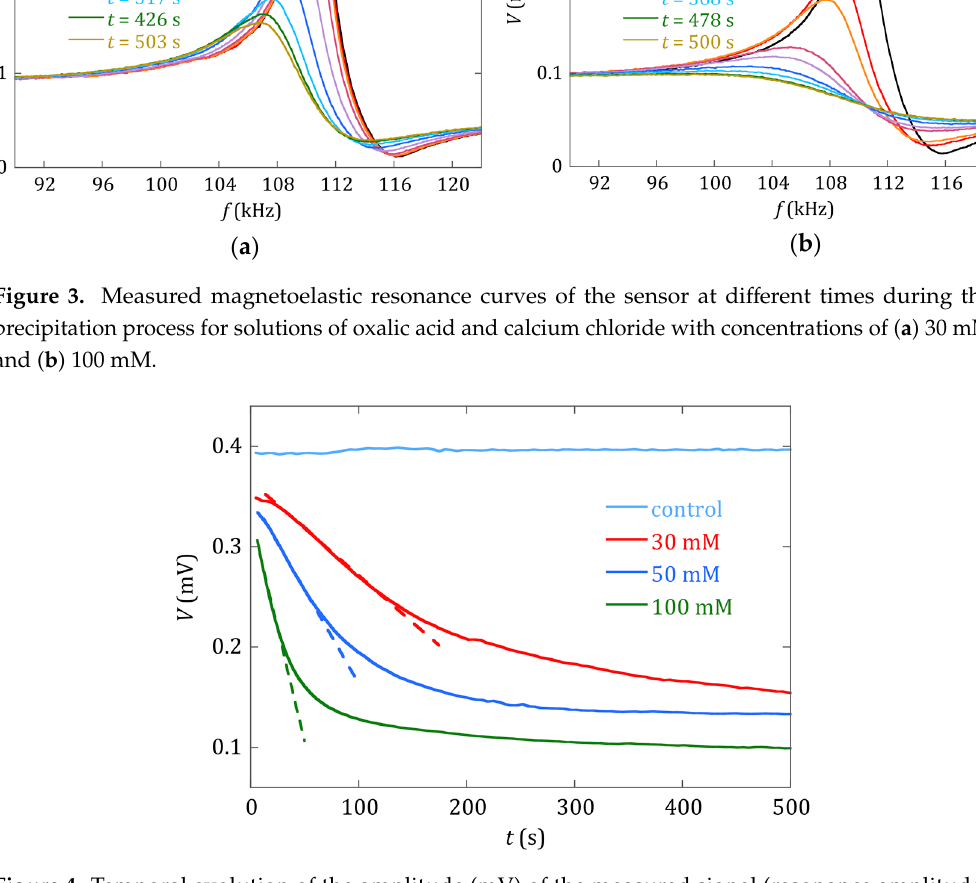
Figure 4. Temporal evolution of the amplitude (mV) of the measured signal (resonance amplitude), as the precipitation reaction progressed and precipitate crystals were deposited on the sensor surface. Curves are shown for different reactant concentrations (30 mM, 50 mM and 100 mM), and a control test (sensor in a vial with distilled water). Linear fits of the initial slope of each voltage curve are shown in dashed lines.